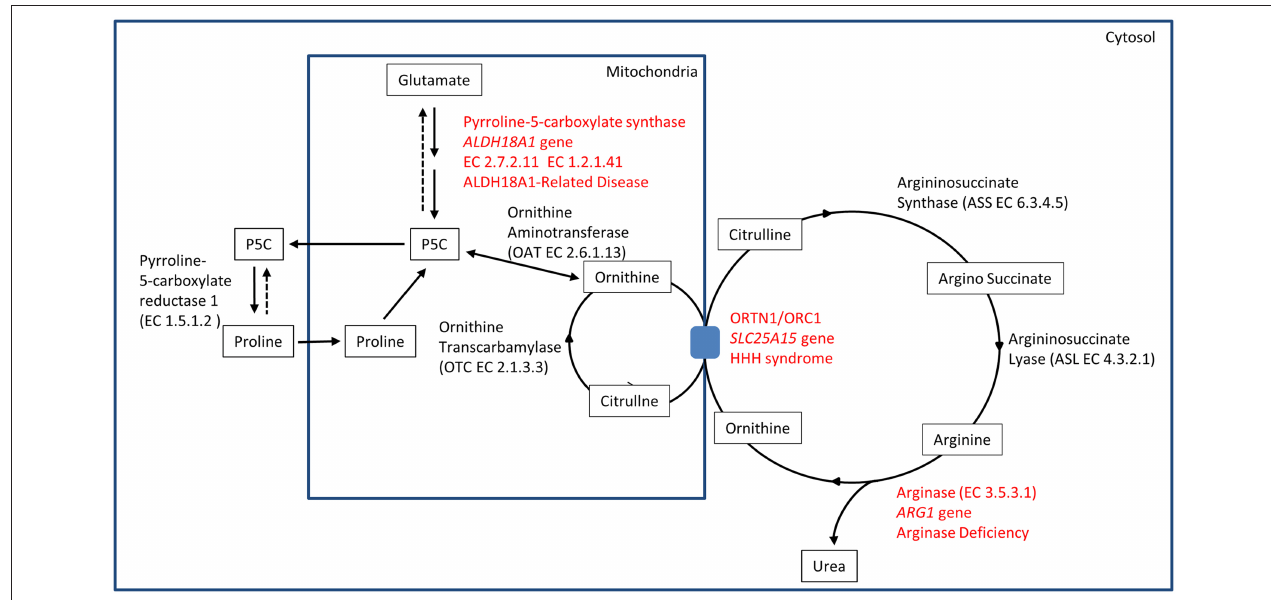
FIGURE 1 | Biochemical